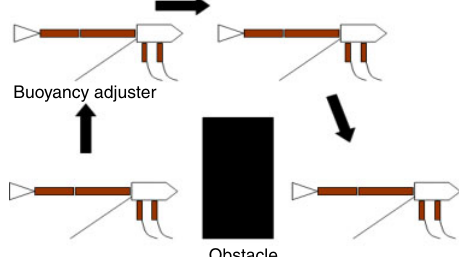
Figure 2 Hybrid underwater micro-robot.